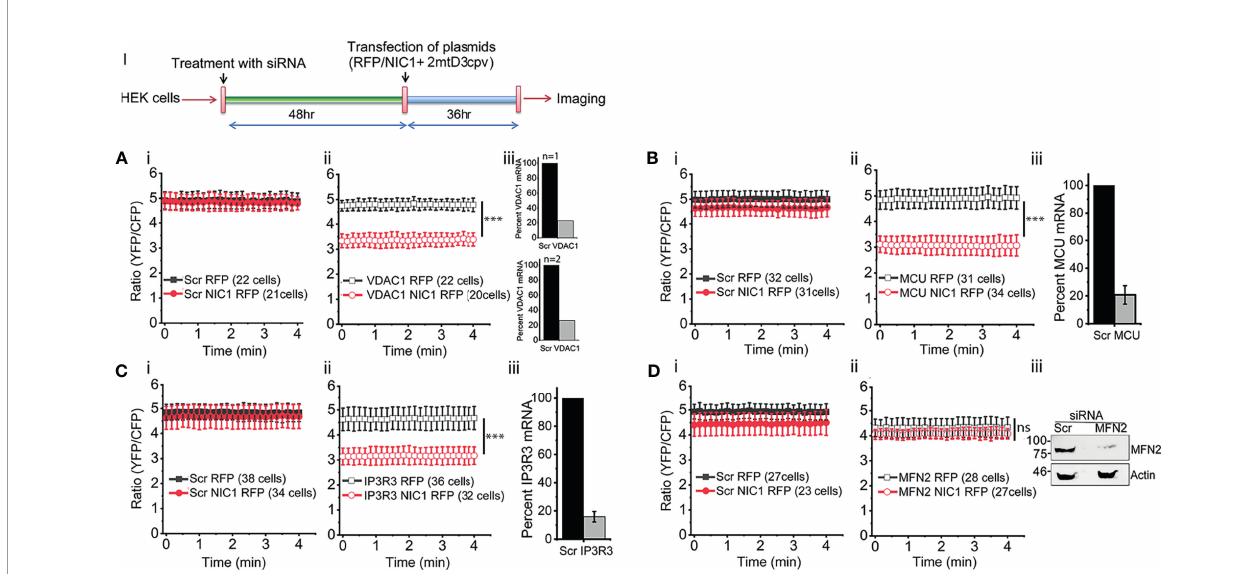
FIGURE 3 | NIC1 signaling maintains mitochondrial calcium levels. Schematic (I) Timeline of experiments, for the assessment of mitochondrial calcium levels. (A – D) Ratio of YFP/CFP fl uorescence in HEK cells, imaged 36 h after co-transfection with 2mtD3cpv and NIC1-RFP ( ⚬ ) or RFP ( ▫ ) in cells pre-treated with siRNA to VDAC1 (A-ii) or MCU (B-ii) , IP3R3 (C-ii) or MFN2 (D-ii) or scrambled control ( A-D-i , NIC1-RFP ( (cid:129) ) and RFP ( ▪ ). (A-C iii) Percent mRNA of the genes as shown in panels, in cells treated with siRNA to VDAC1 ( A , N=2) or MCU ( B , N=3) or IP3R3 ( C , N=3) and scrambled control. (D-iii) Representative immunoblot of whole cell lysates from cells treated with siRNA to MFN2 or scrambled control probed for MFN2 and Actin. Data plotted as mean ± SD of the indicated number of cells in 6-12 fi elds across two (A, D) or three (B, C) experiments. *** indicates signi fi cant difference at any time point with p ≤ 0.001 and ns: not signi fi cant, examined using the unpaired student ’ s